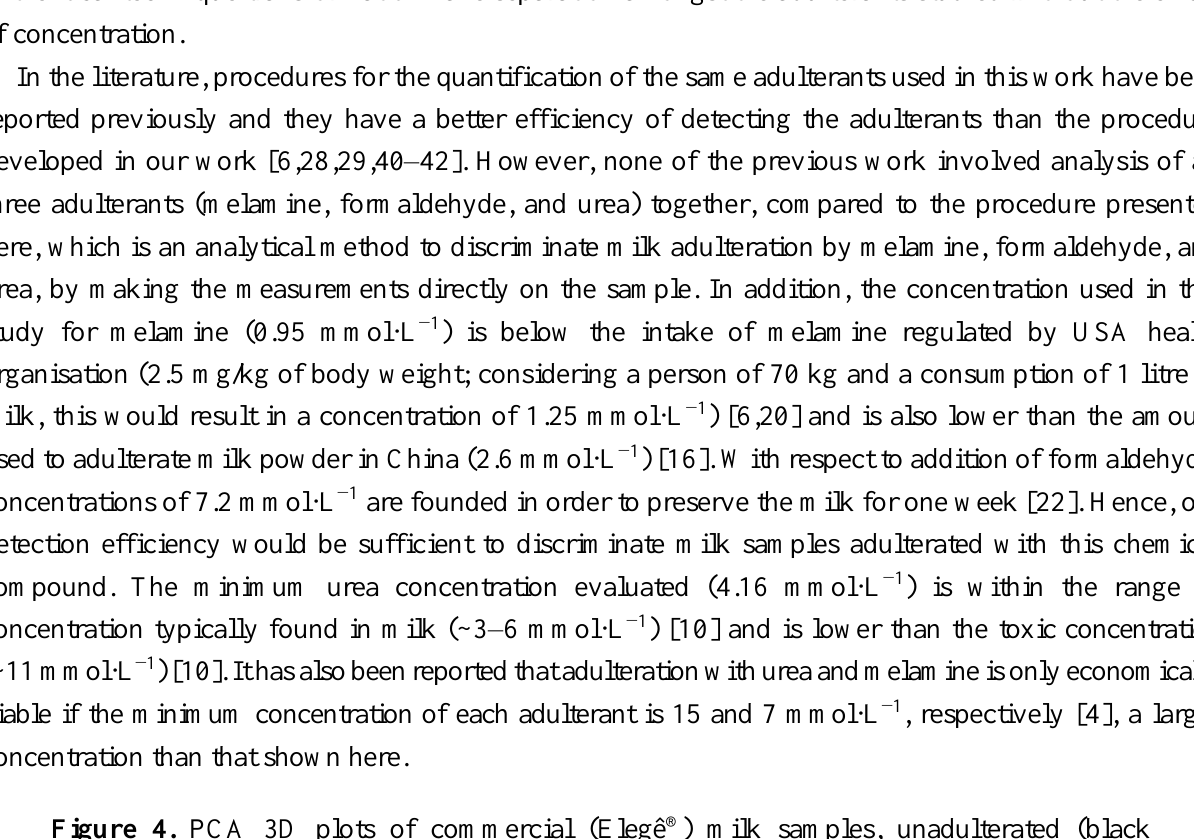
Figure 4. PCA 3D plots of commercial (Elegê ® ) milk samples, unadulterated (black squares), and adulterated with 10.0 mmol·L −1 of formaldehyde (red circles), 0.95 mmol·L −1 of melamine (blue up triangles), and 4.16 mmol·L −1 of urea (green down triangles). Skimmed milk ( A ) and semi-skimmed milk ( B ). Samples were analysed in